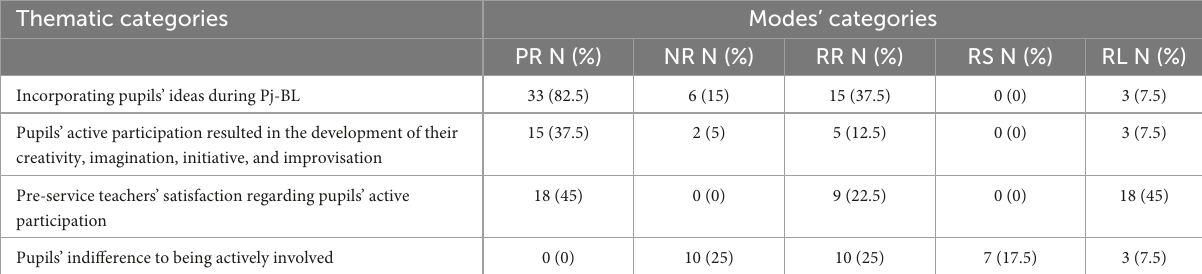
TABLE 4 Pre-service teachers’ modes of expressing pupil active involvement during project-based learning (Pj-BL). Thematic